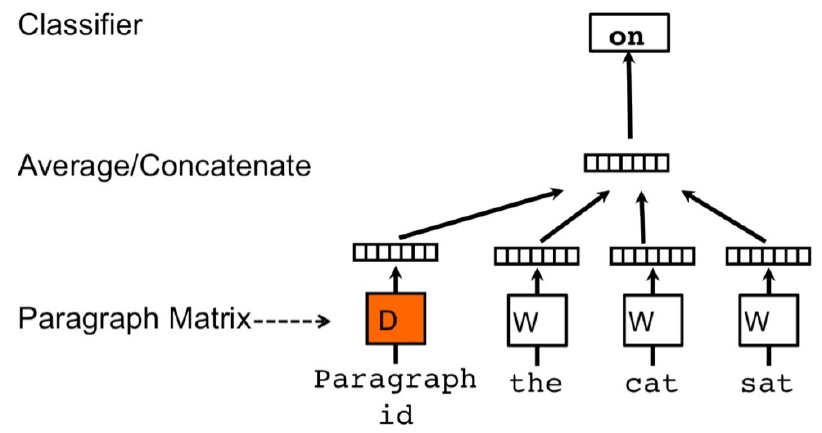
Figure 4. Distributed memory model of paragraph vectors (PV ‐ DM) architecture.